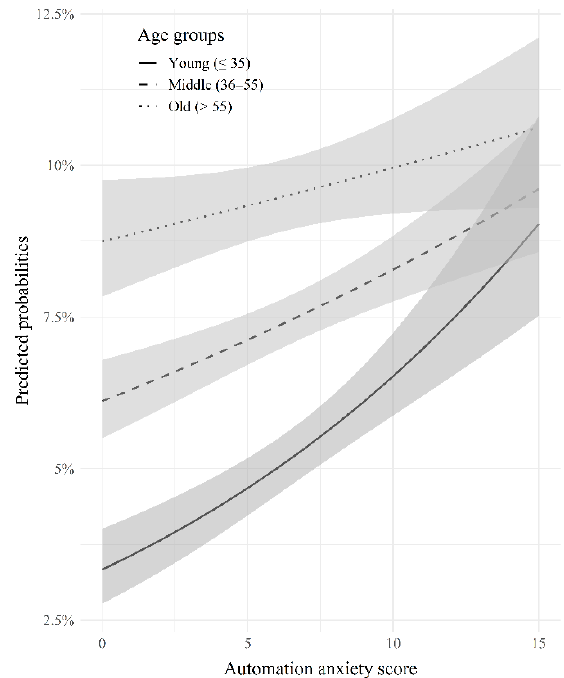
Figure 2. Average predicted probabilities for sleep disturbance of three age groups. Predictions were based on multivariate logistic regression with interaction terms (Model D). Table 4. Stratified analyses by each age subgroup in a fully-adjusted model. Bold indicates statistically significant values. [OR: odds ratio; CI: confidence